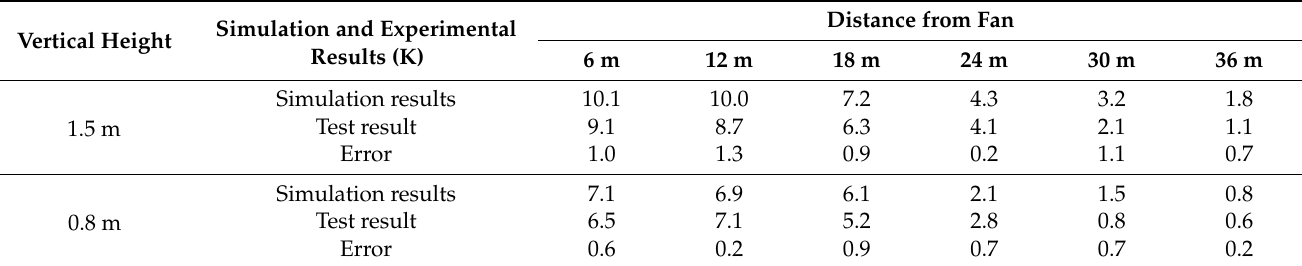
Table 9. Simulation results, test results, and errors of each test